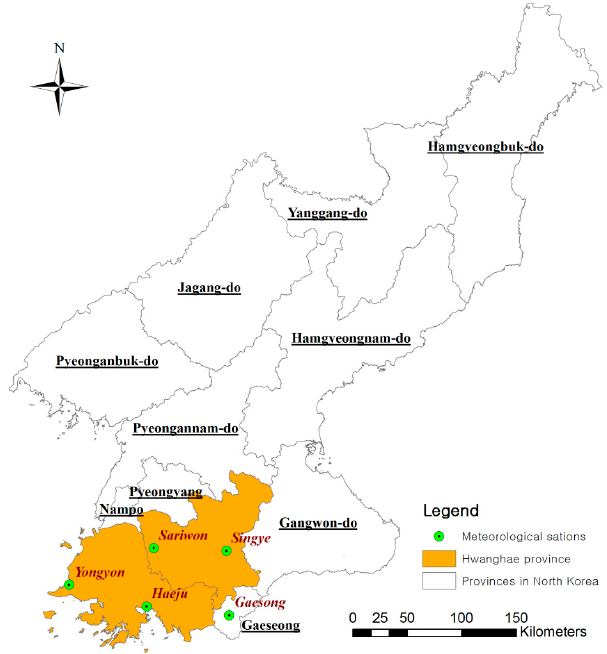
Figure 1. Meteorological stations in the Hwanghae Plain, North Korea.